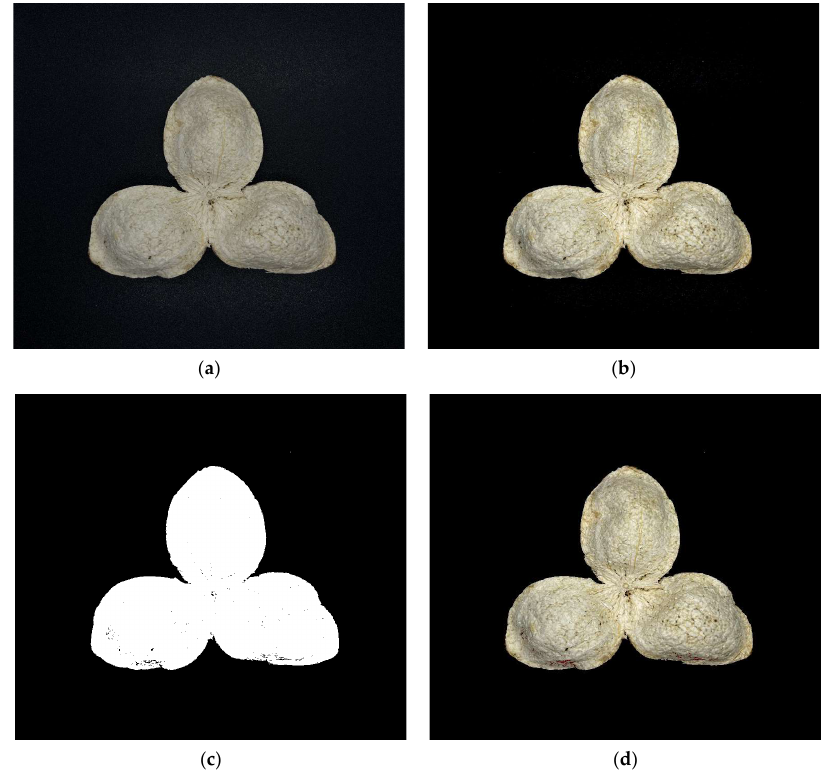
Figure 10. Image characterization of a non-moldy PCRC sample. ( a ) Original image of PCRC without mildew; ( b ) Image after denoising and contrast optimization; ( c ) Image segmented by EXR and Otus methods; ( d ) The stacking image sample.